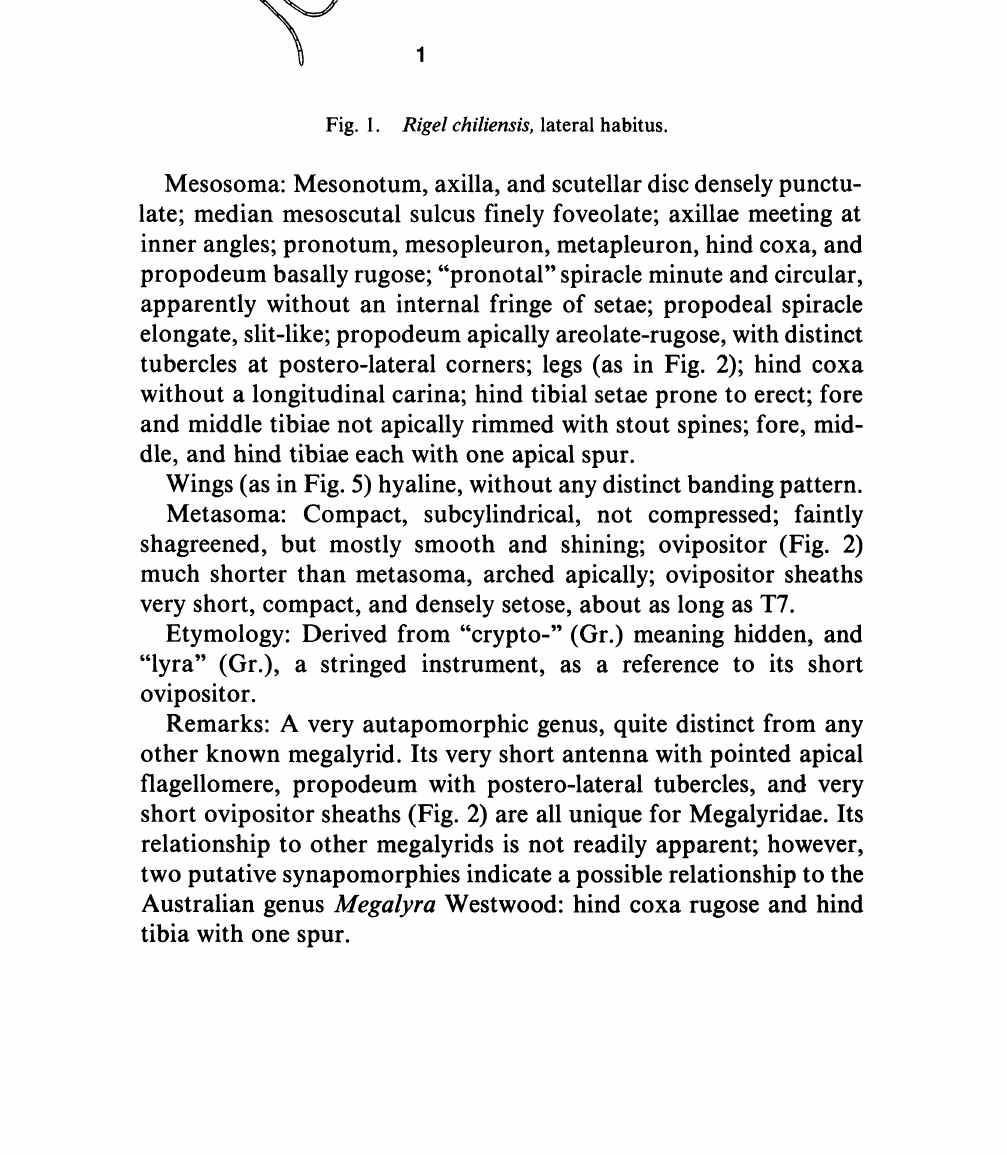
Fig. 1. Rigel chiliensis, lateral